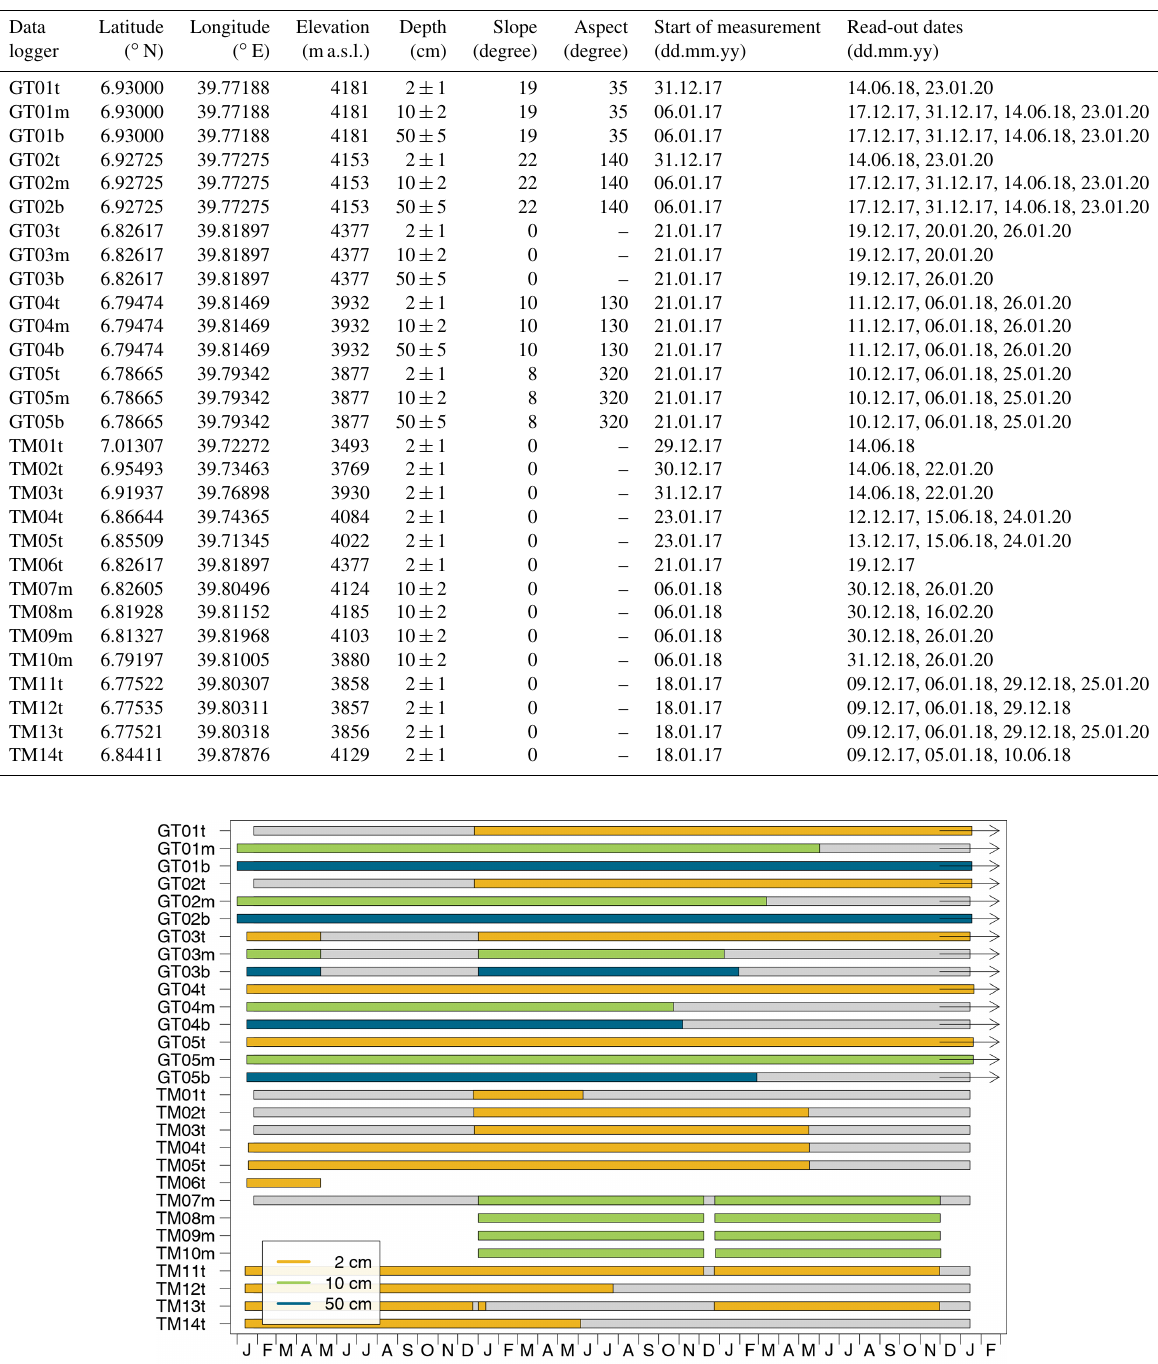
Table 1. Overview of the 29 ground temperature data loggers (excluding lost items) installed in the Bale Mountains. The measuring depth of a logger is indicated by the lower-case letters t (top, 2cm), m (middle, 10cm), and b (bottom, 50cm). Data